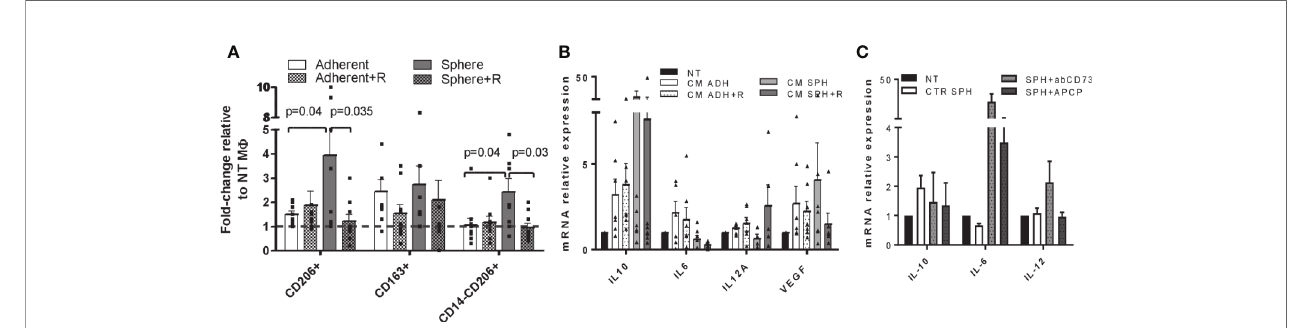
FIGURE 5 | CM from spheroids induces TAM polarization that can be prevented by CXCR4 inhibition. (A) FACS analysis for CD206, CD163, and CD14 expression in macrophages derived from PBMCs of healthy volunteers treated with CM from adherent or spheroids, treated or not with peptide R. Data are the fold-change in % of positive cells compared to control macrophages cultured in proper control medium (RPMI 10% for adherent cells and SCM for spheroids). N=2 independent experiments were performed for each tested NSCLC cell lines. (B) Real-Time PCR quanti fi cation of IL-10, IL-6, IL-12, VEGF gene expression in macrophages derived from PBMCs of heavy smoker volunteers treated with CM from adherent or spheroids, treated or not with peptide R. Control macrophages cultured in proper control medium (RPMI 10% for adherent cells and SCM for spheroids) were used as calibrator. N=2 independent experiments were performed for